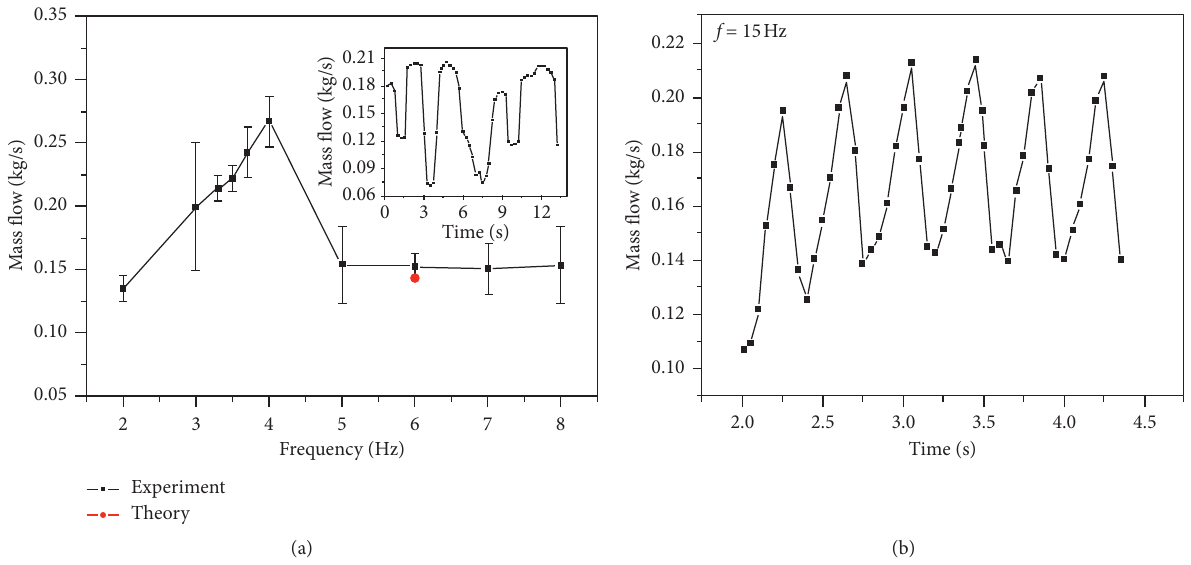
Figure 5: (a) Variation of the flow rate with elevated frequency. (b) Mass flow of the screw conveyor with time at f � 15Hz simulated with